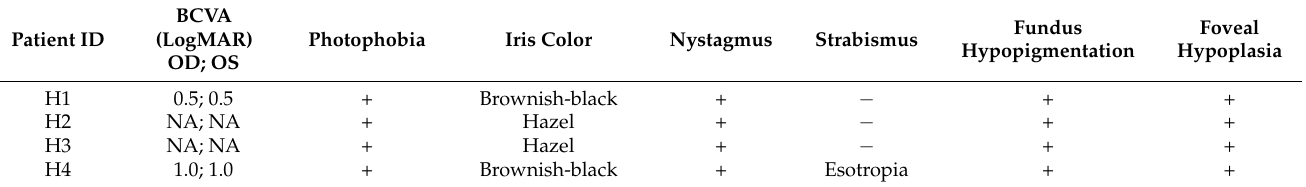
Table 2. Ocular features of the HPS patients.